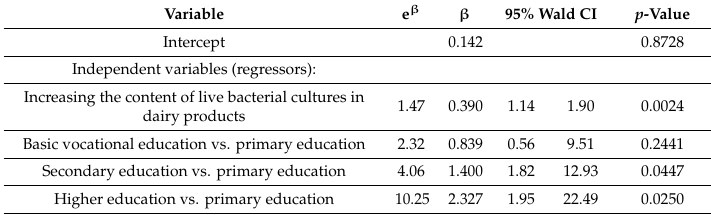
Table 7. Prediction of the acceptance of production ensuring welfare of farm animals. Variable e β β 95% Wald CI p -Value Intercept 0.142